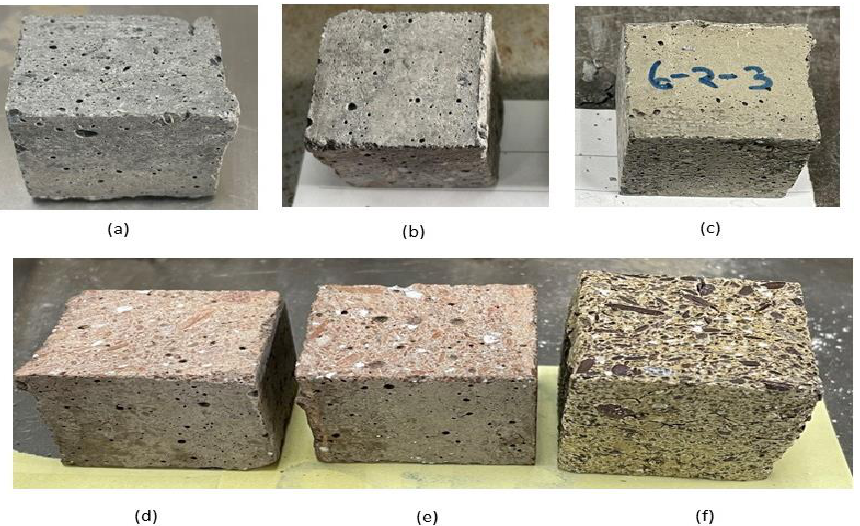
Figure 22. Geopolymer specimens after exposure to various heating temperatures (°C): ( a ) unex-